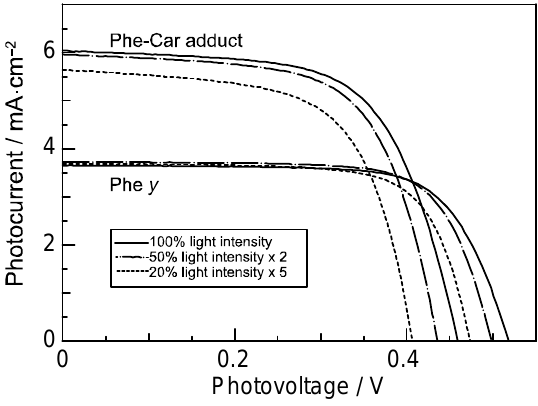
Figure 29. The light-intensity dependence of the I − V curves in solar cells using the Phe y and Phe–Car adduct sensitizers (reprinted from [19], Copyright (2007), with permission from